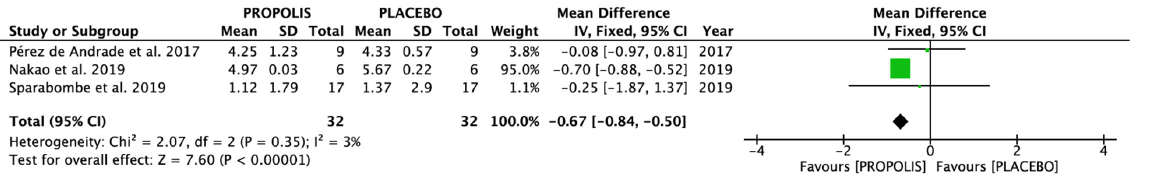
Figure 2. Forest